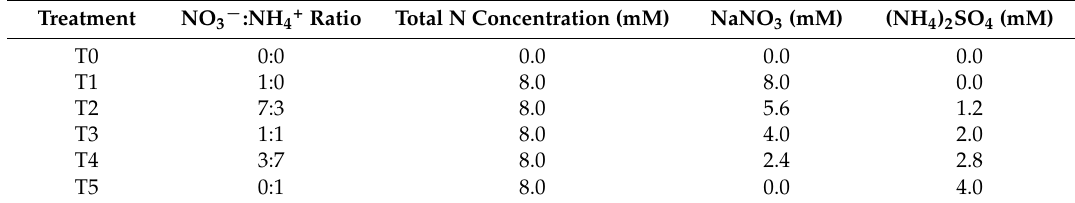
Table 1. Six ratios of NO 3 − and NH 4+ used for studying effects of nitrogen forms on Camellia oleifera ‘Xianglin 27’ seedling